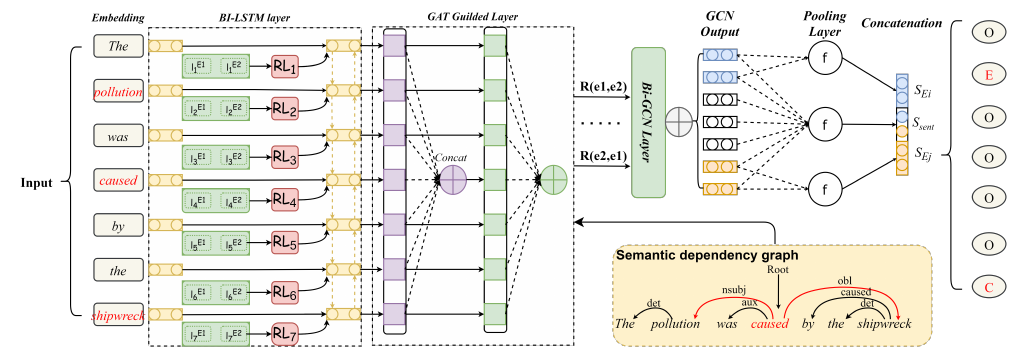
Figure 5. Framework diagram of causal extraction model